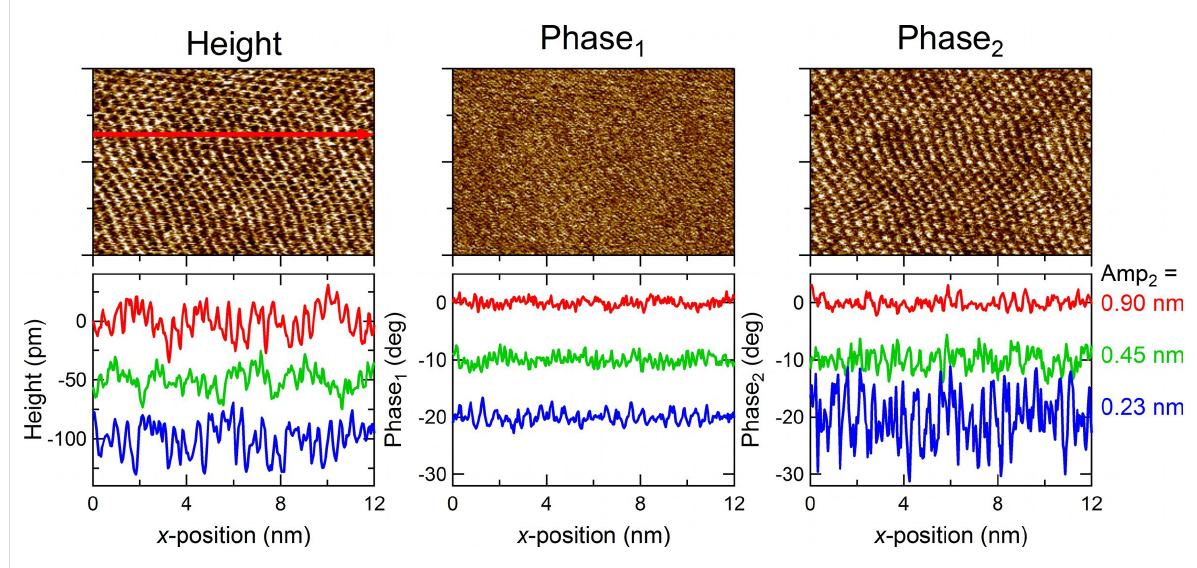
Figure 6: Top row: 8 × 12 nm 2 height, 1st phase shift, and 2nd phase shift images of a mica surface imaged in ultrapure water in AM-OL mode. Bottom row: single scan lines for three different 2nd mode amplitudes (0.90, 0.45, 0.23 nm). Parameters: rectangular silicon cantilever (PPP- NCSTAuD, Nanosensors), 1st free amplitude = 1.5 nm, amplitude setpoint = 0.75